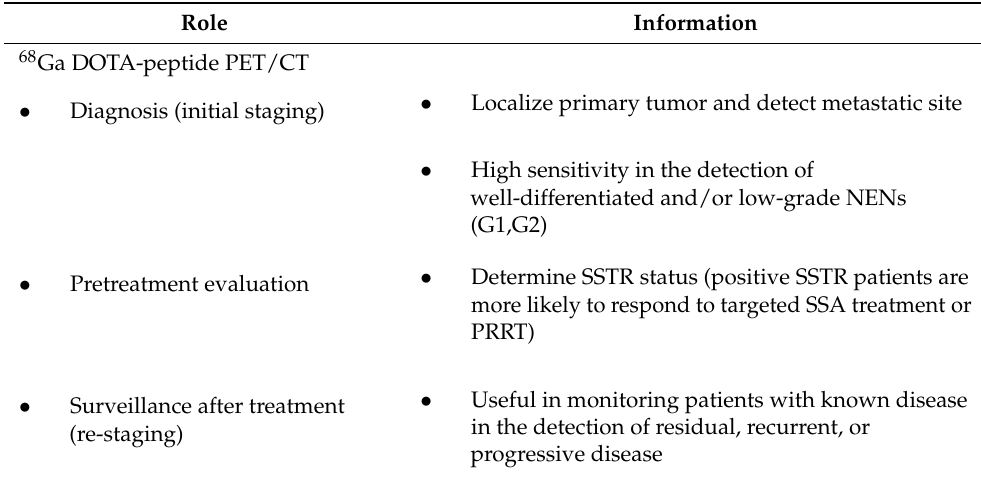
Table 4 the role of SSTR PET and FDG PET in GEP-NENs. Table 4. Role of SSTR PET and 18 F FDG PET in